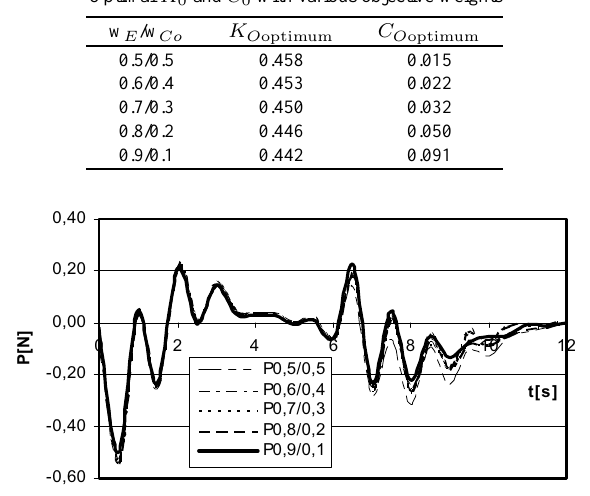
Fig. 5. Optimal control for impact absorber (Case II).